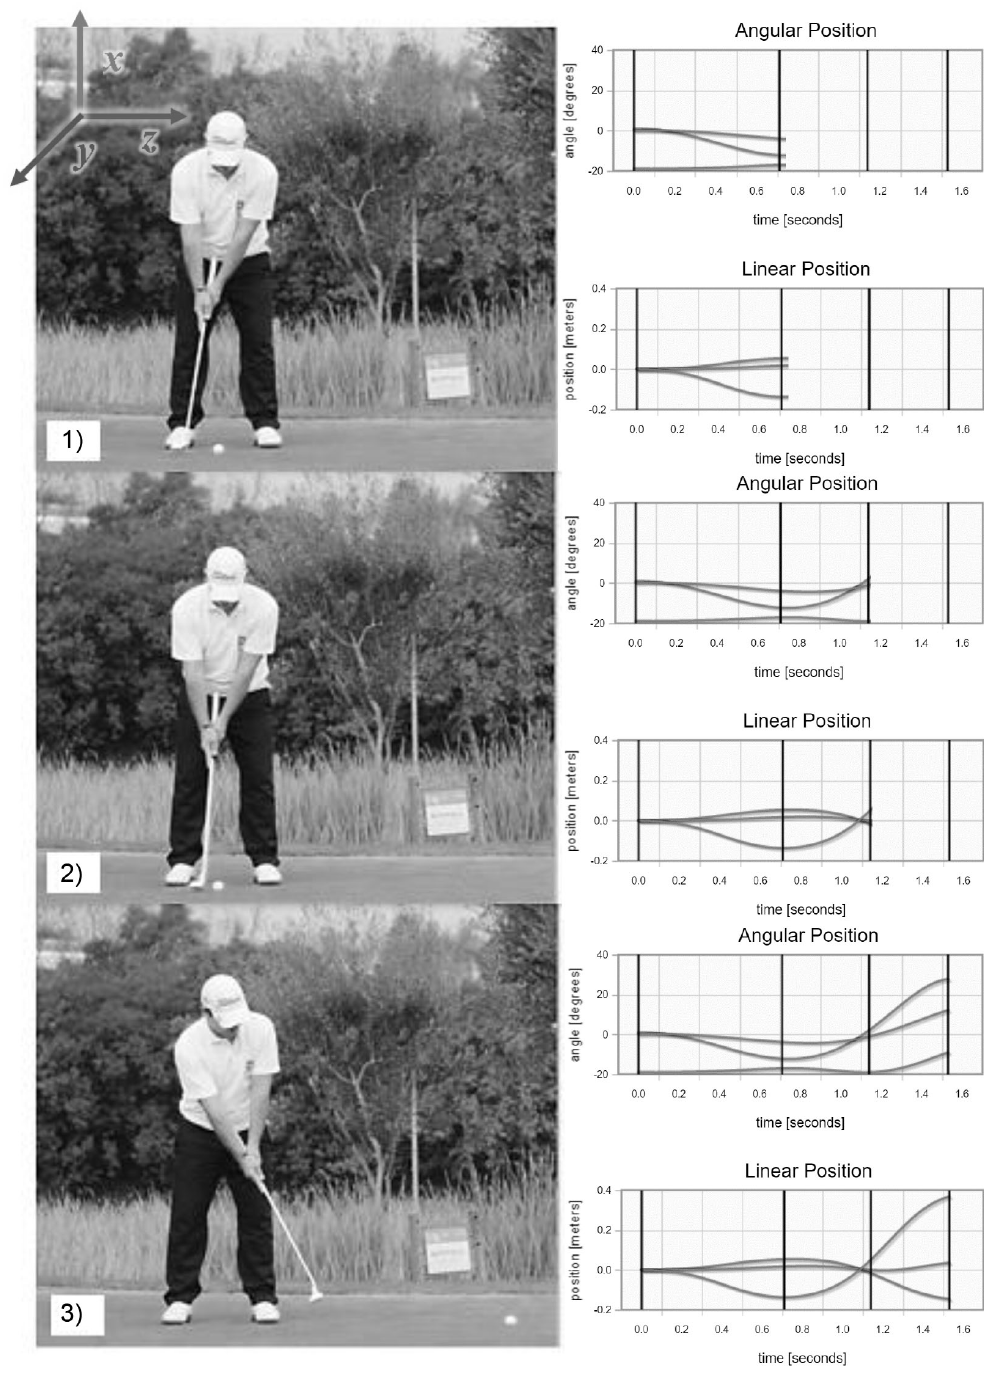
Fig. 1. Sequence executed by the European Champion of Pitch and Putt. (Left) Experimental setup with InPutter. (Right) Kinematic data with each phase of the putting identified in real-time: (1) Backswing. (2) Downswing and ball impact. (3) Follow-through